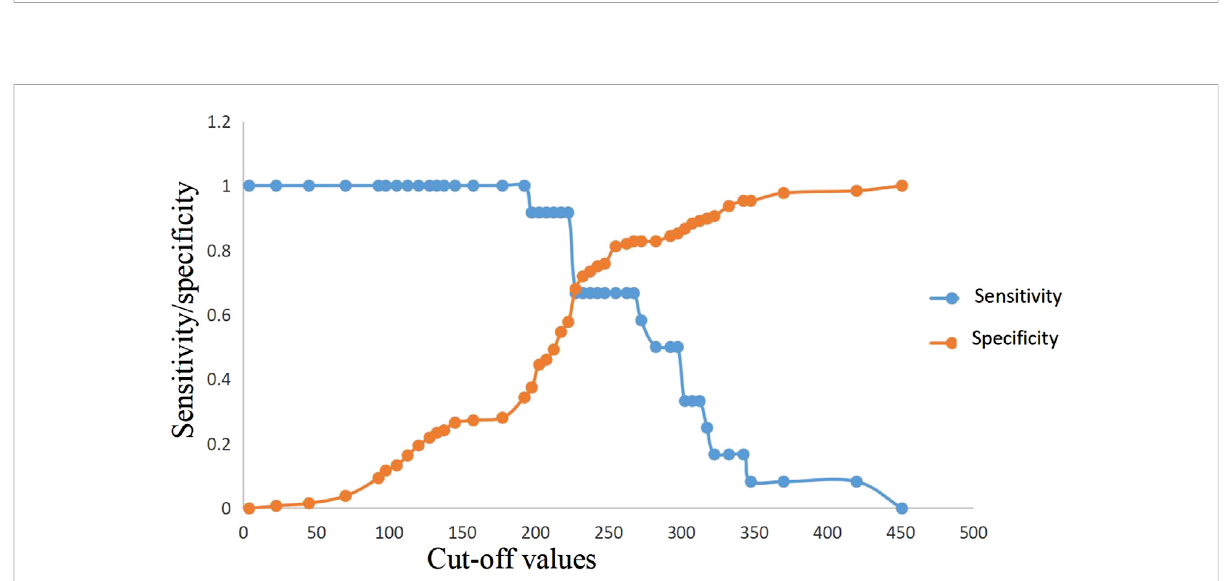
FIGURE 7 Sensitivity and speci fi city curves of PASS score in in-hospital mortality prediction in the presence of different cut-off values. PASS: pancreatitis activity scoring